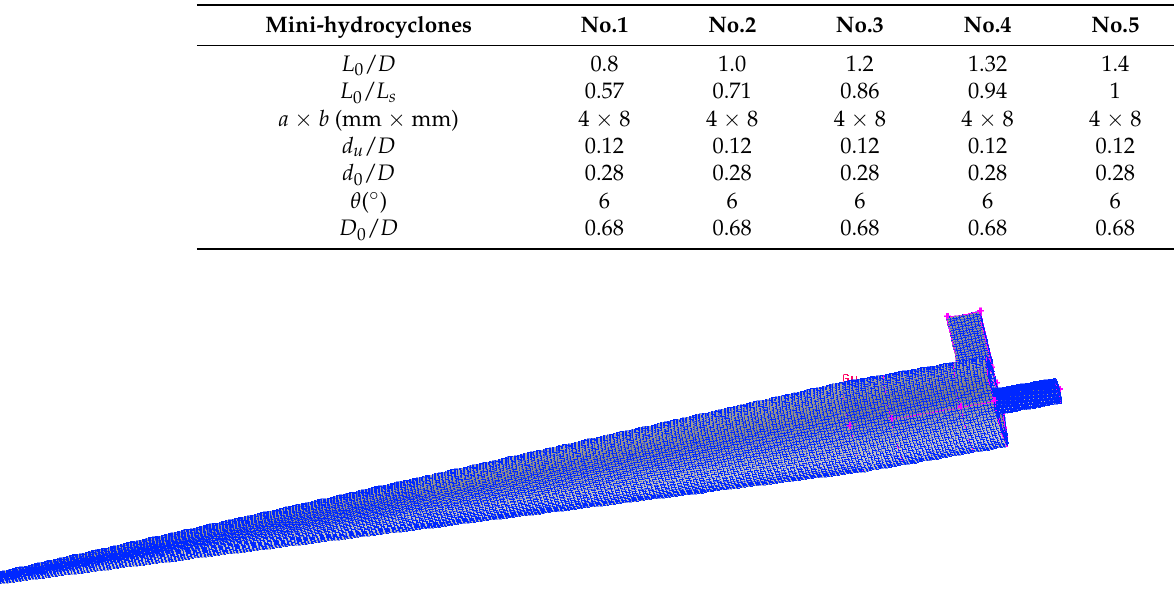
Figure 2. Grids of mini-hydrocyclones computational domain